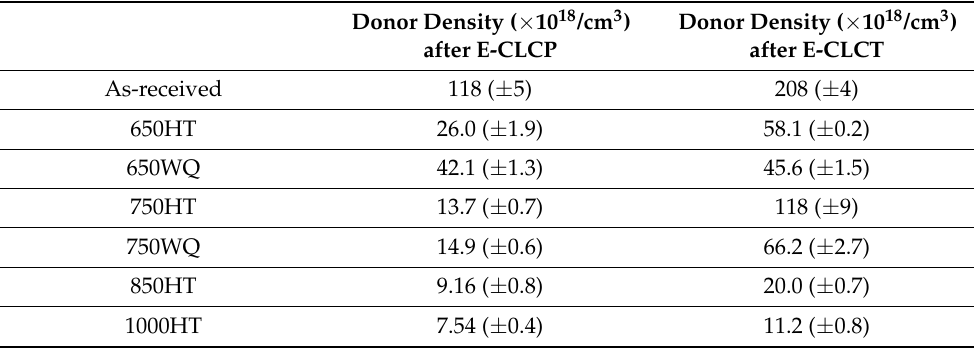
Table 5. Mott–Schottky data for corroded sites after the E-CLCP and E-CLCT tests of the as-received and heat-treated samples of the AM Ti–6Al–4V